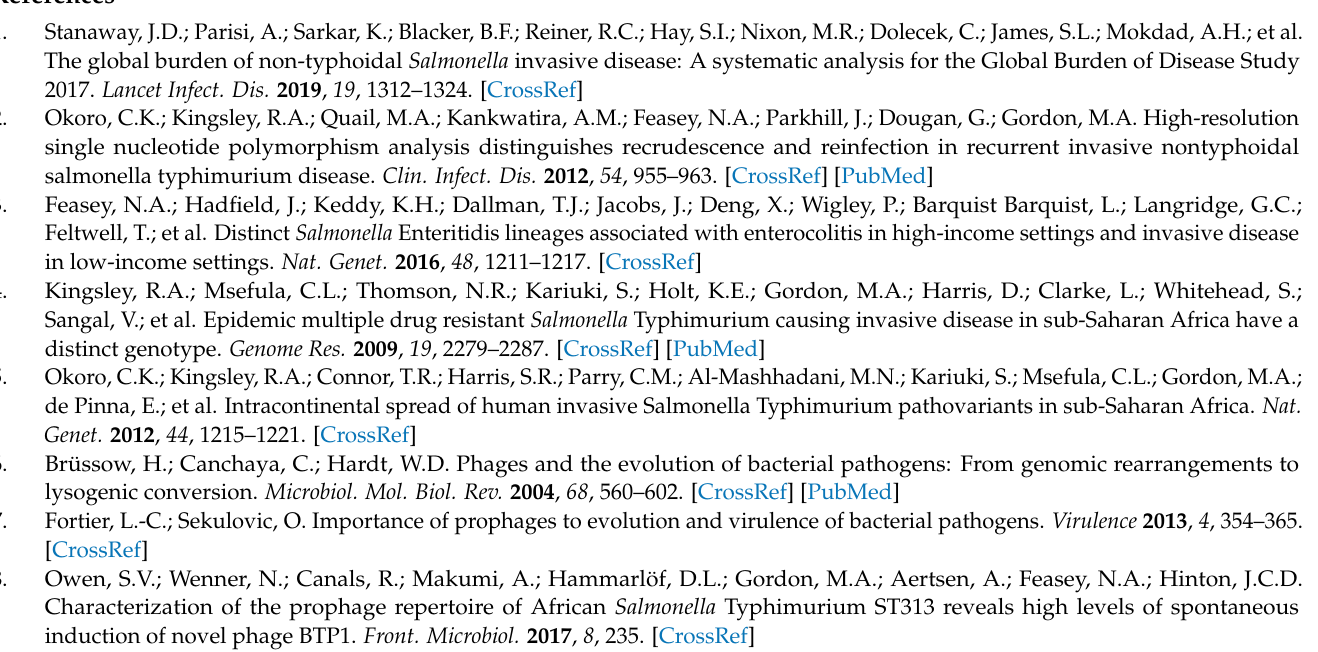
cleotide used in this study, Table S2: BPS6 genome annotation, Table S3: ER6 genome annotation, Table S4: ER22 genome annotation, Table S5: ER20 genome